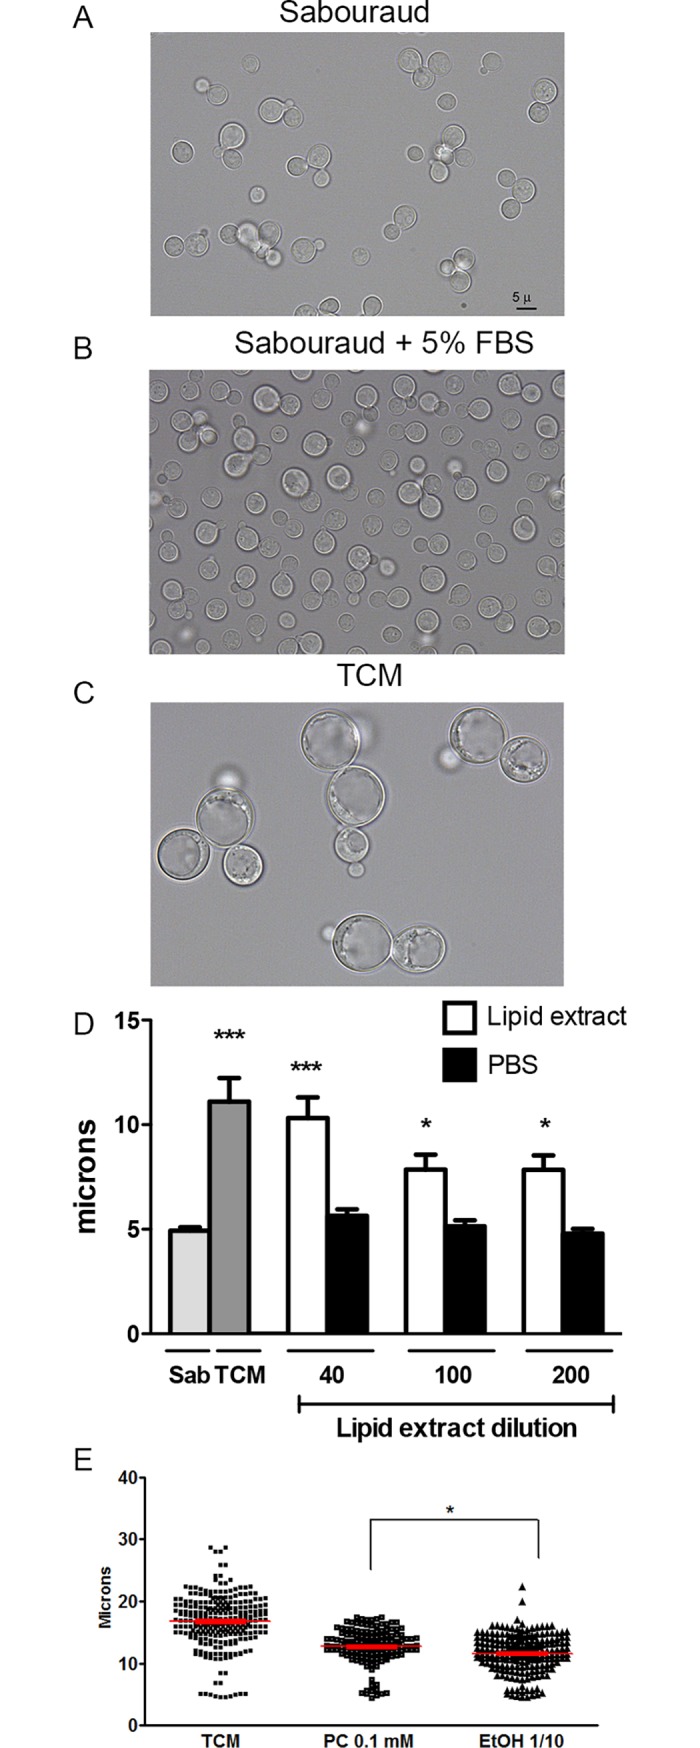
Effect of serum on cryptococcal cell growth.H99 cell suspensions were inoculated in Sabouraud (A), Sabouraud supplemented with 5% serum (B) or TCM (C). The cells were incubated overnight at 37°C in 5% CO2. Then, the cells were suspended in India Ink and pictures of the cell body size were taken. The scale in A applies to all the pictures. (D) Effect of purified serum lipids on cell growth. The cells (initial density 104 cells/mL) were grown in TCM medium in which the serum was replaced by different dilutions (40, 100 and 200) of the lipid extract. As controls, the same media was supplemented with PBS. Cultures in TCM are also included for reference. Cell body size was determined after 24 hours at 37° C with CO2 and shaking. The asterisks indicate significant differences compared to Sabouraud control. (E) Effect of phosphatydilcholine on titan-like cell formation. Cells were incubated as in (A), but serum was replaced by 0.1 mM of phosphatidylcholine (PC). A parallel control with the same concentration of ethanol was carried out in parallel. The graph shows the cell body size.